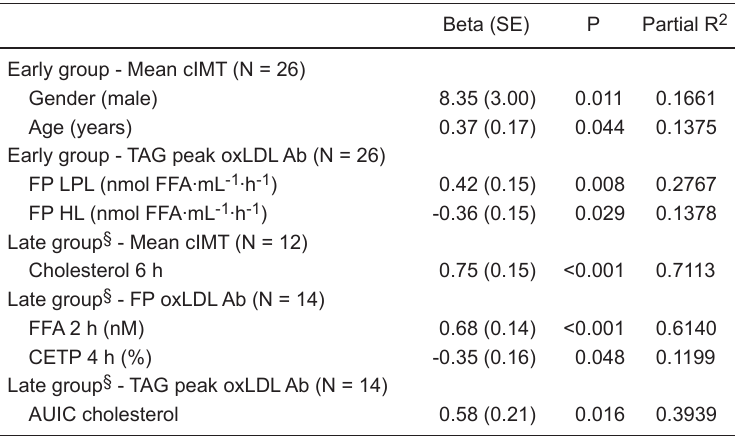
Table 3. Relationships of early carotid atherosclerosis and antibodies against oxidized LDL with anthropometric and metabolic parameters in early and late re-